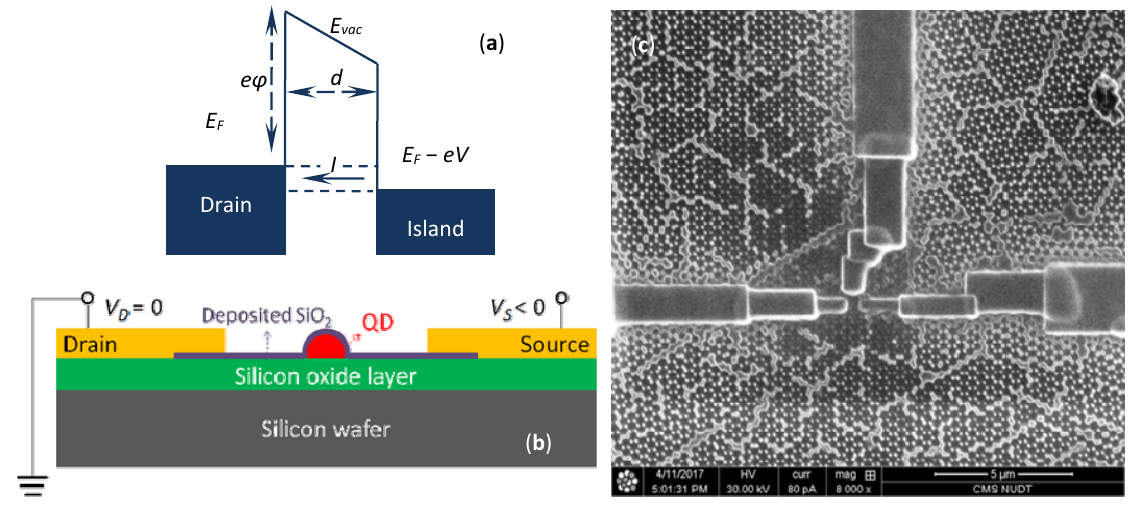
Figure 4. ( a ) Band diagram of electrode-dielectric-gold nanoparticle junction; ( b ) Schematic diagram of the side view of the SET device; ( c ) SEM image of the top view of the SET device. Table 1. The atomic concentrations of the dual beam-induced resultants.